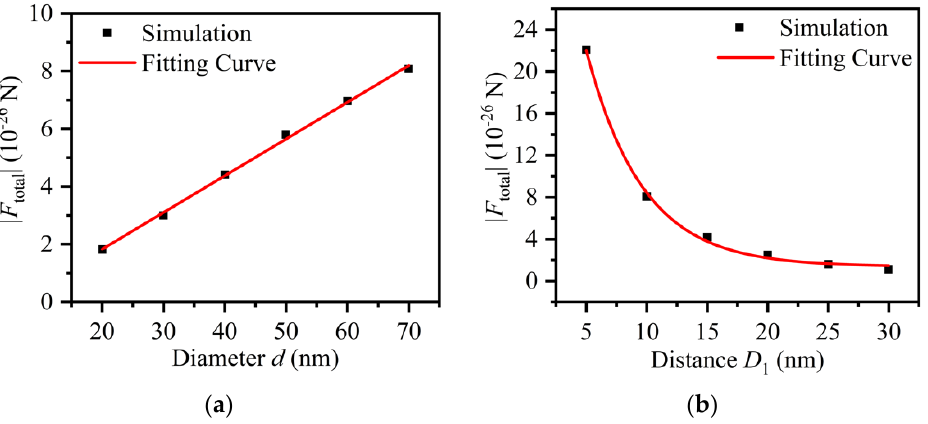
Figure 6. Total trapping force induced by VP laser with wavelength 717 nm as functions of some critical factors. ( a ) Diameter of NP; ( b ) Distance between the tip and the NP.